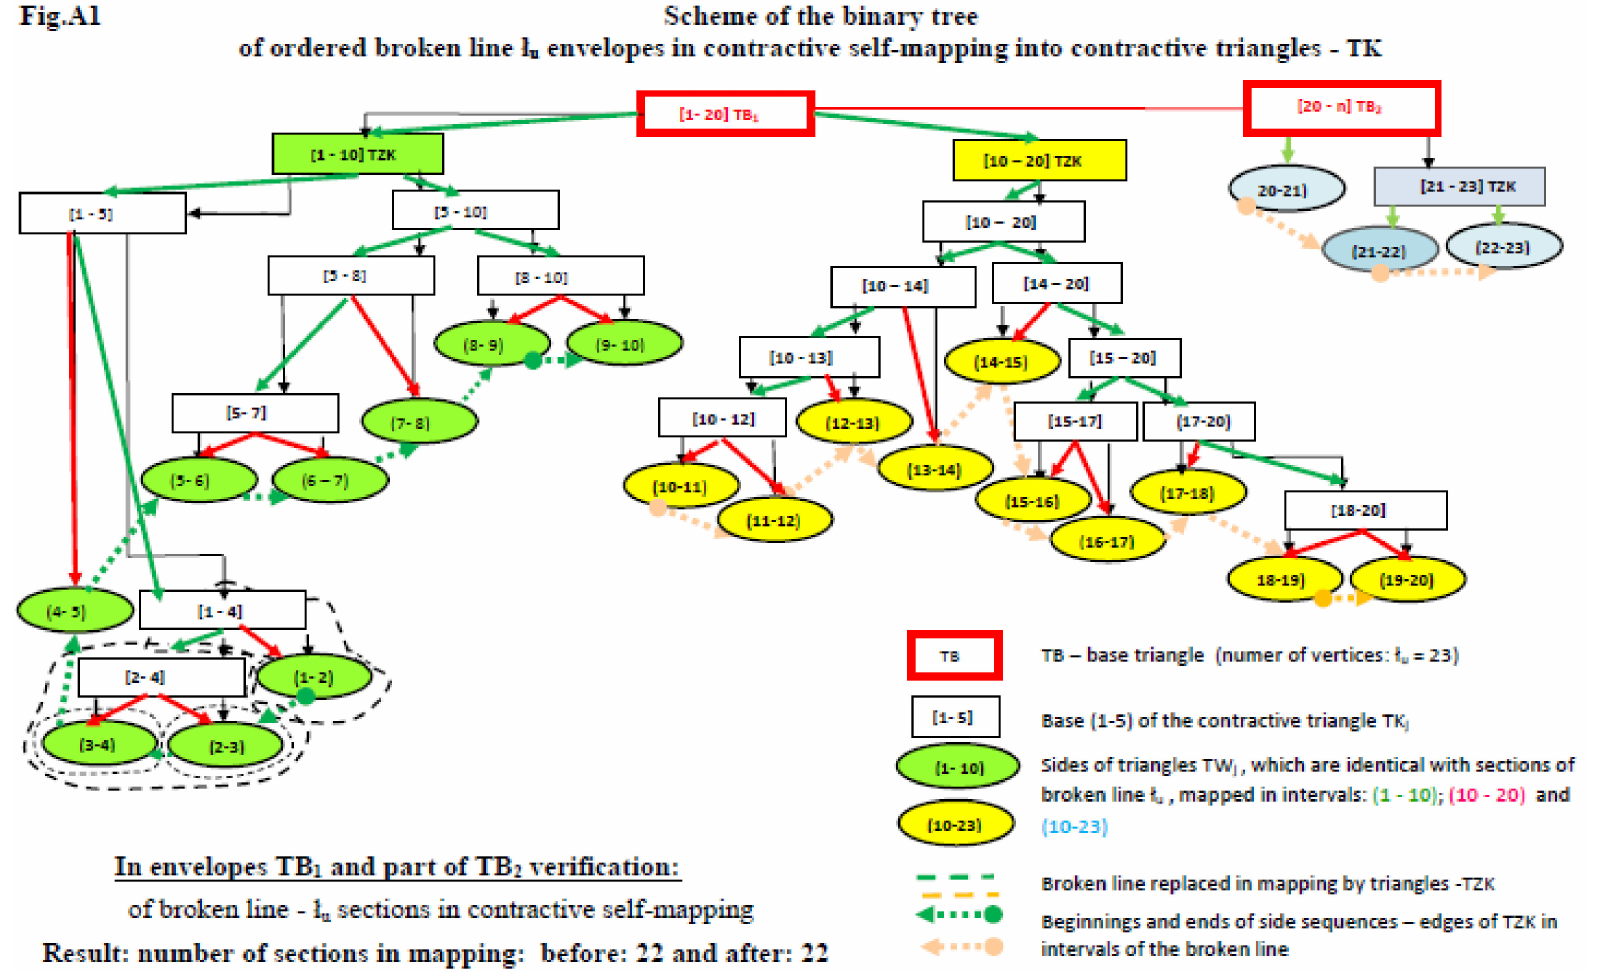
Figure A1. Scheme of the binary tree of polyline (ordered broken line) l u envelopes, in contractive self-mapping into contractive triangles TK